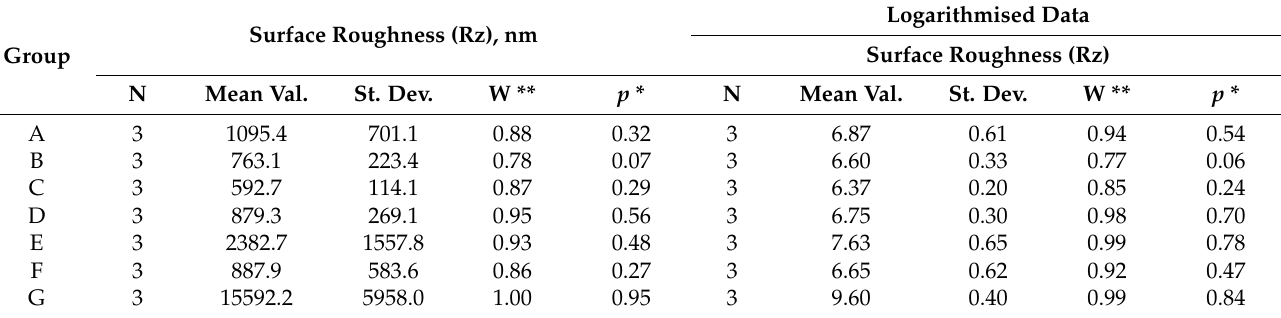
Table 3. Test of normality of surface roughness data (Rz).